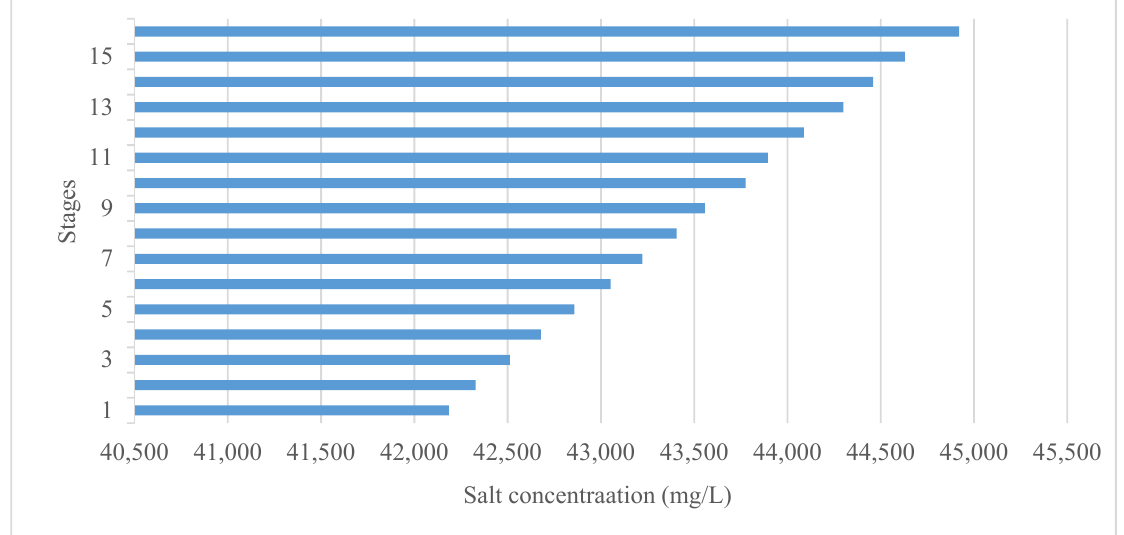
Figure 13. Salt concentration change in brine water (feed water).